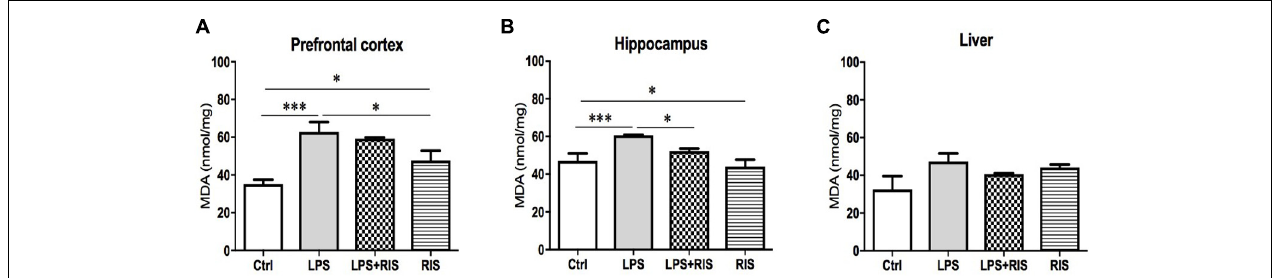
FIGURE 1 | Effect of various treatments on the level of lipid peroxidation (MDA). Groups are Ctrl (control), LPS (lipopolysaccharide), LPS+RIS (lipopolysaccharide + risperidone), and RIS (risperidone). The level of MDA was assayed from the prefrontal cortex (A) , hippocampus (B) , and liver (C) tissues. Values are represented as mean ± SEM. Post hoc multiple comparison test namely, “Newman–Keuls” test was used to compare between groups. n = 6 per group. ∗ p < 0.05, ∗∗ p < 0.01, ∗∗∗ p < 0.001.